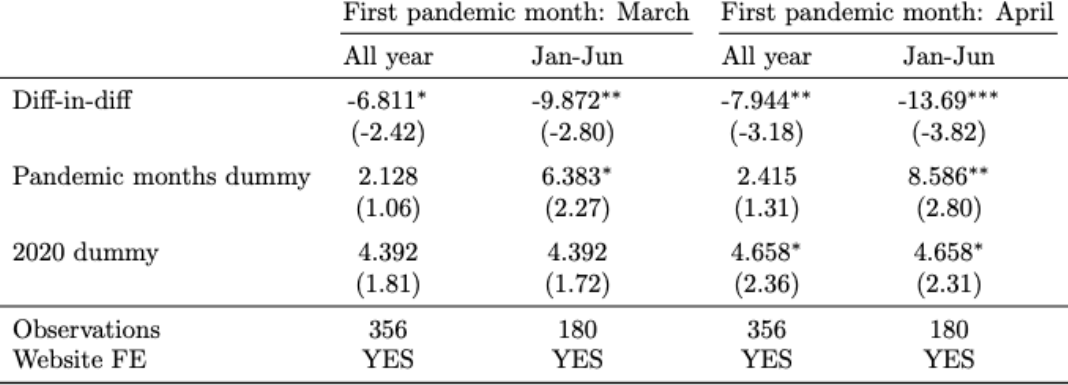
Table A4. Difference-in-differences analyses - Per-post